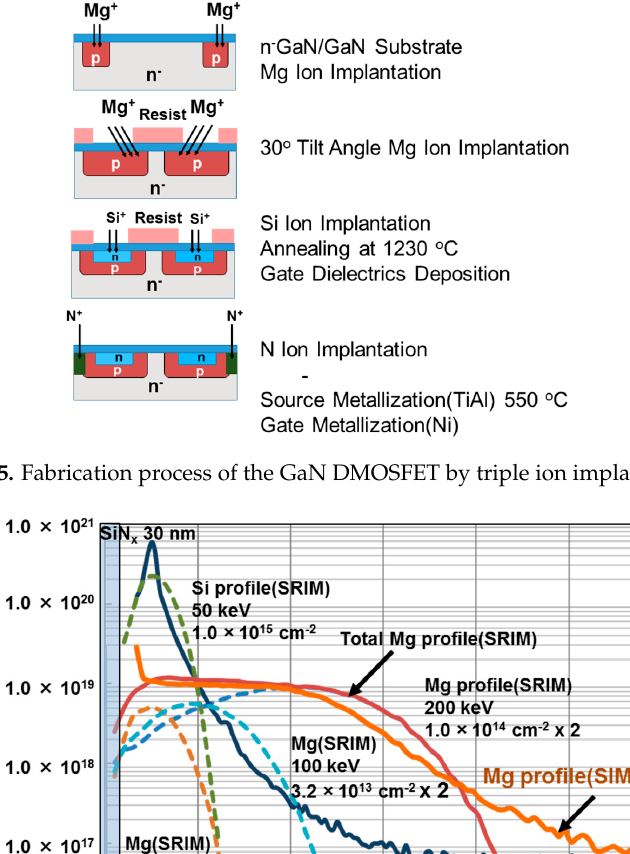
Figure 4. Schematic cross section of the fully ion implanted vertical GaN DMOSFET.